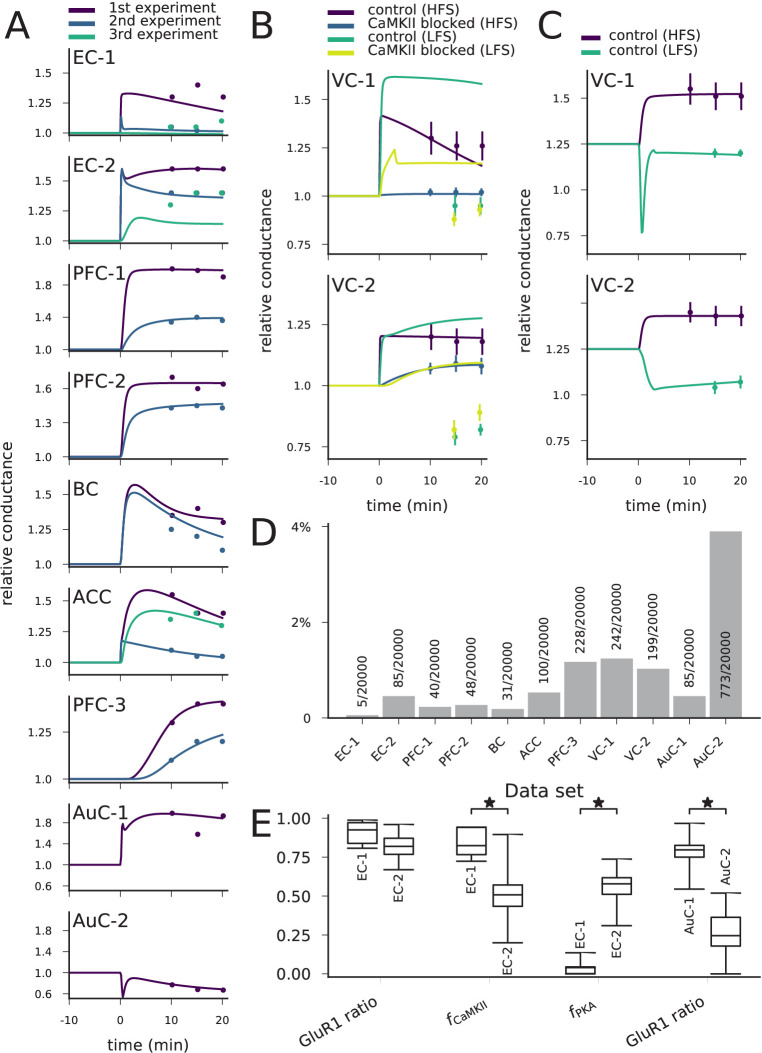
The model can be fit to LTP/LTD data from different cortical areas.(A) The model could be fit to LTP/LTD data from data sets EC-1 (top), EC-2, PFC-1, PFC-2, BC, ACC, PFC-3, AuC-1, and AuC-2 (bottom). The curves represent the model predictions of the best-fit parameter sets, and the dots represent the experimental data from Table 2. For data sets other than AuC-1 and AuC-2, several experiments with various chemical agents or genetic mutations were performed for each neuron population: these are ordered as in Table 2 (e.g., in data set EC-1, purple (1 st experiment) corresponds to control, blue (2nd experiment) to CaMKII-blocked experiment, and green (3rd experiment) to the experiment where post-synaptic Ca2+ was blocked). (B) The model could not be fit to the complete LTP/LTD data from data sets VC-1 (top) and VC-2 (bottom). The best parameter sets correctly predicted the LTP/LTD in up to two experiments (e.g., the selected parameter sets reproduce the HFS data with and without CaMKII inhibitor, but failed to reproduce the LFS data). (C) The model could be fit to the LTP/LTD data from data sets VC-1 (top) and VC-2 (bottom) when CaMKII-blocked experiments were ignored. The vertical bars in (B) and (C) represent the SD from the experimental data. (D) Proportion of accepted parameter sets across the 20 generations of multi-objective optimisation (20’000 parameter sets in total) in each data set. (E) Box plots of selected parameters in the acceptable parameter sets of data sets EC-1 and EC-2 (three left-most pairs) and AuC-1 and AuC-2 (right-most pair). Values of fCaMKII and fPKA are linearly scaled such that the values 0 and 1 correspond to 0 and double the original value of the underlying parameters, respectively (CaM and CaMKII for fCaMKII, and R, Gs, AC1, and AC8 for fPKA, see Materials and methods, section 'Parameter alterations and model fitting'). The medians were significantly different in the compared data sets (U-test, p-value<0.001).